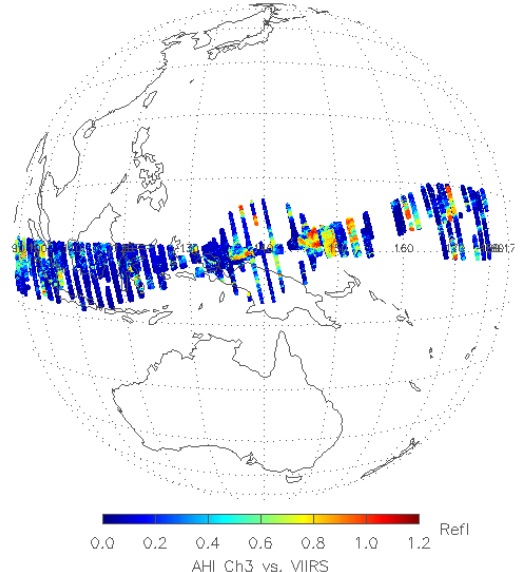
Figure 5. Spatial distribution of Ray-matched collocations within ±10° latitude for the collocation data collocated from 20 June to 20 August